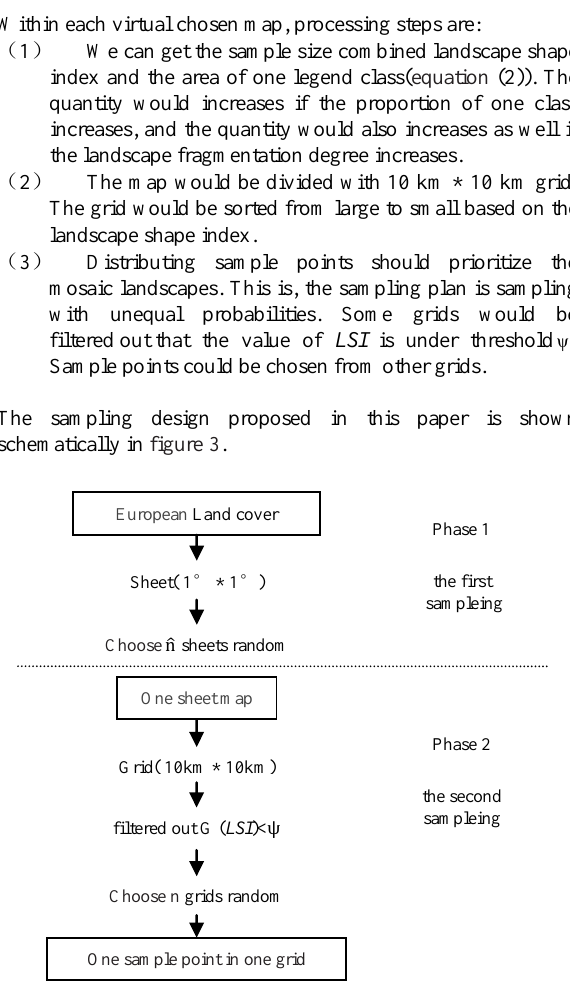
Figure 3.The method of landscape Indices based